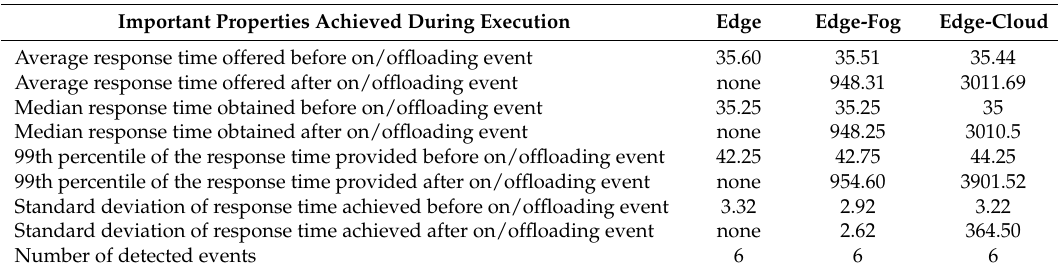
Table 4. Properties achieved in all different experiments.